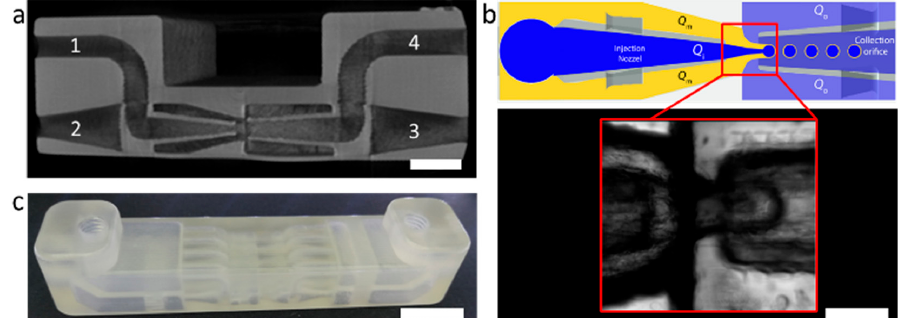
Figure 2. ( a ) µ CT scan of the double emulsification element. The acrylate material appears in light gray color and the channel structure in darker contrast. The numbers indicate the in- and outlets: ( 1 ) inlet fluid for inner droplet, ( 2 ) inlet for midlle phase (shell droplet), ( 3 ) inlet continuous phase, ( 4 ) outlet for sample collection. ( b ) Schematic of the double emulsification process with symbols for driving pressures of the respective inlets. The zoomed inset displays a brighfield microscopy image of the droplet generation zone showing the formation of a double emulsion droplet. ( c ) Photograph of the 4-fold parallelized doulbe emulsion drop-maker device with connection points for push-in fittings. Scale bars represent ( a ) 1.5 mm, ( b ) 450 µ m, and ( c ) 5